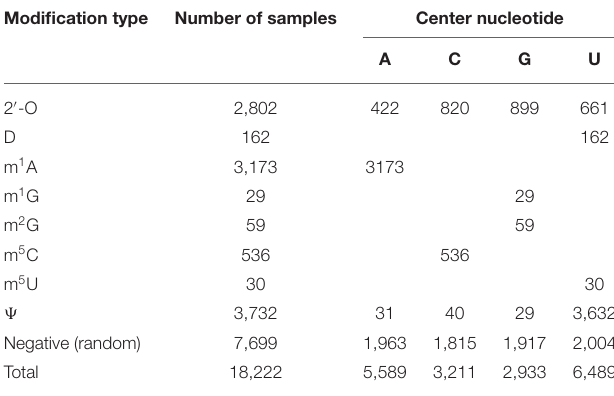
TABLE 1 | Number of samples for different transcriptome modifications in the benchmark